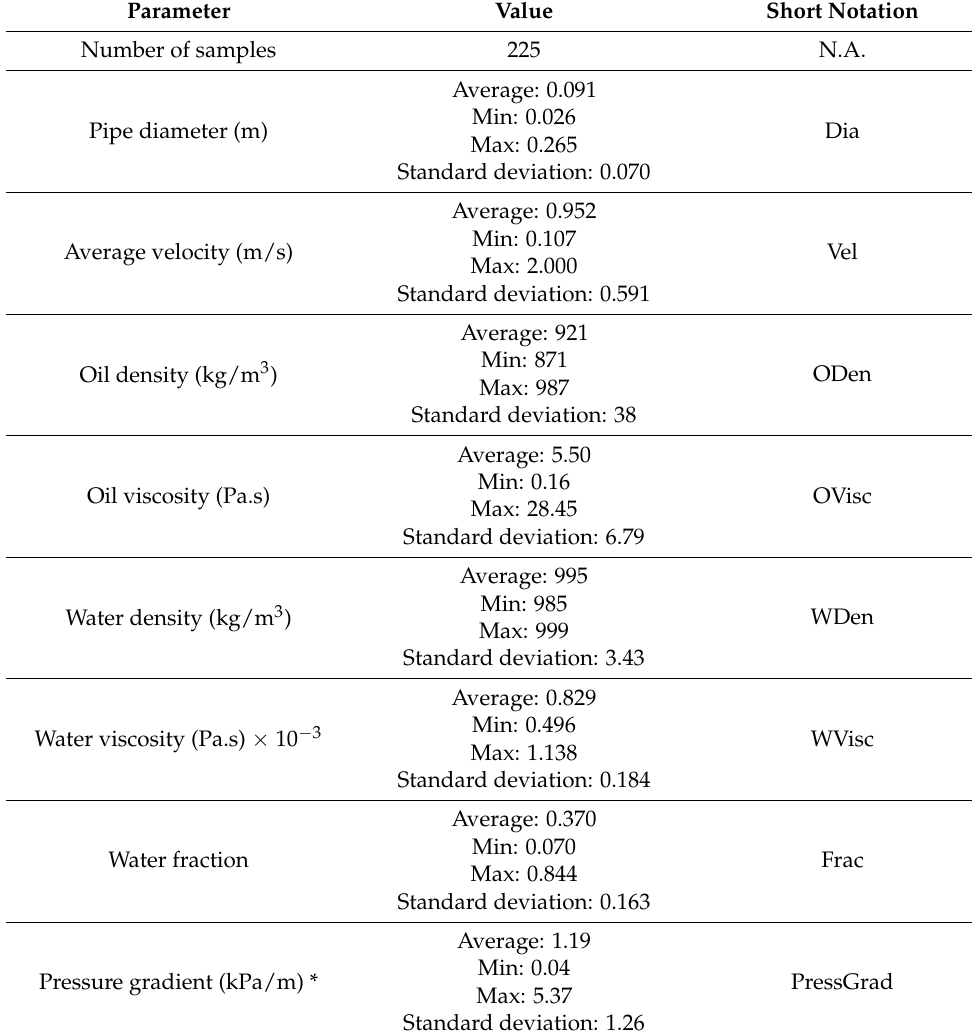
Table 1. Experimental